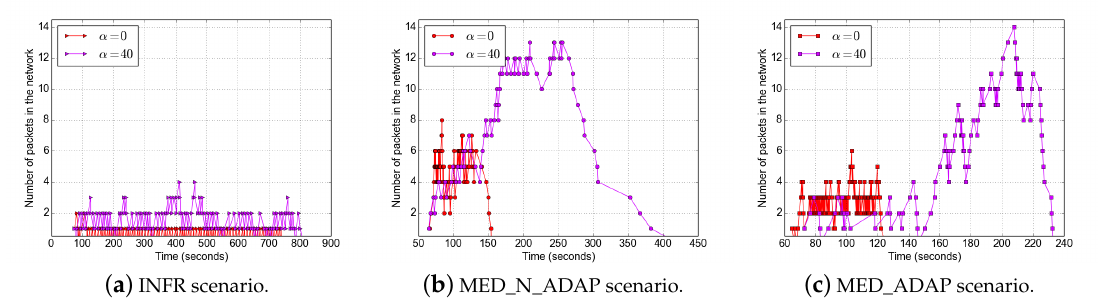
Figure 13. Evolution of the number of packets in the